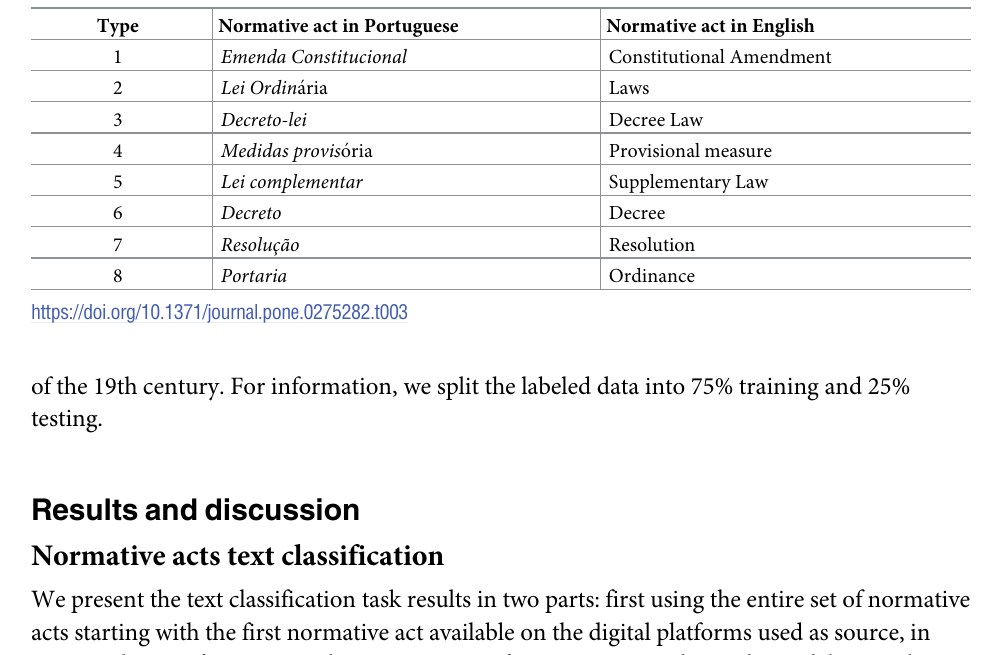
Table 3. Normative acts information.